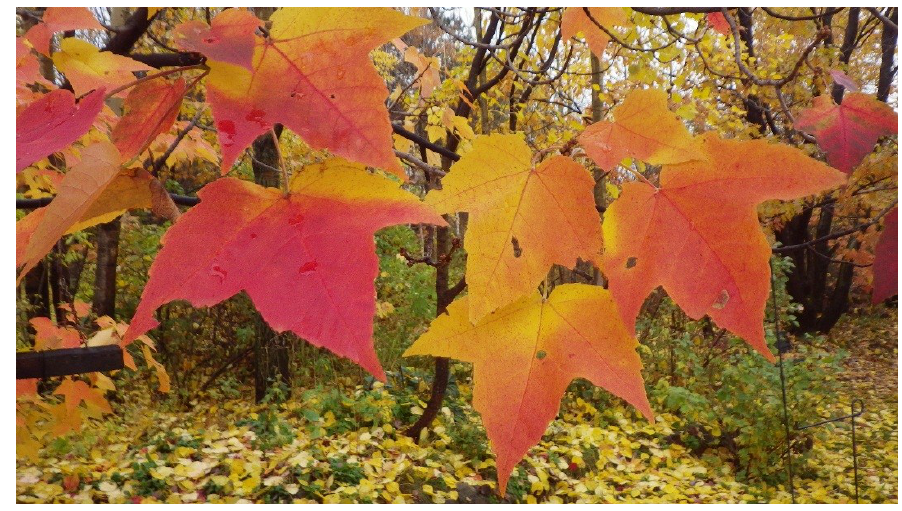
Figure 1. Variation in the red colour during senescence within leaves of Acer rubrum as a result of partial shading by other leaves. Pictures taken on 18 October 2014.